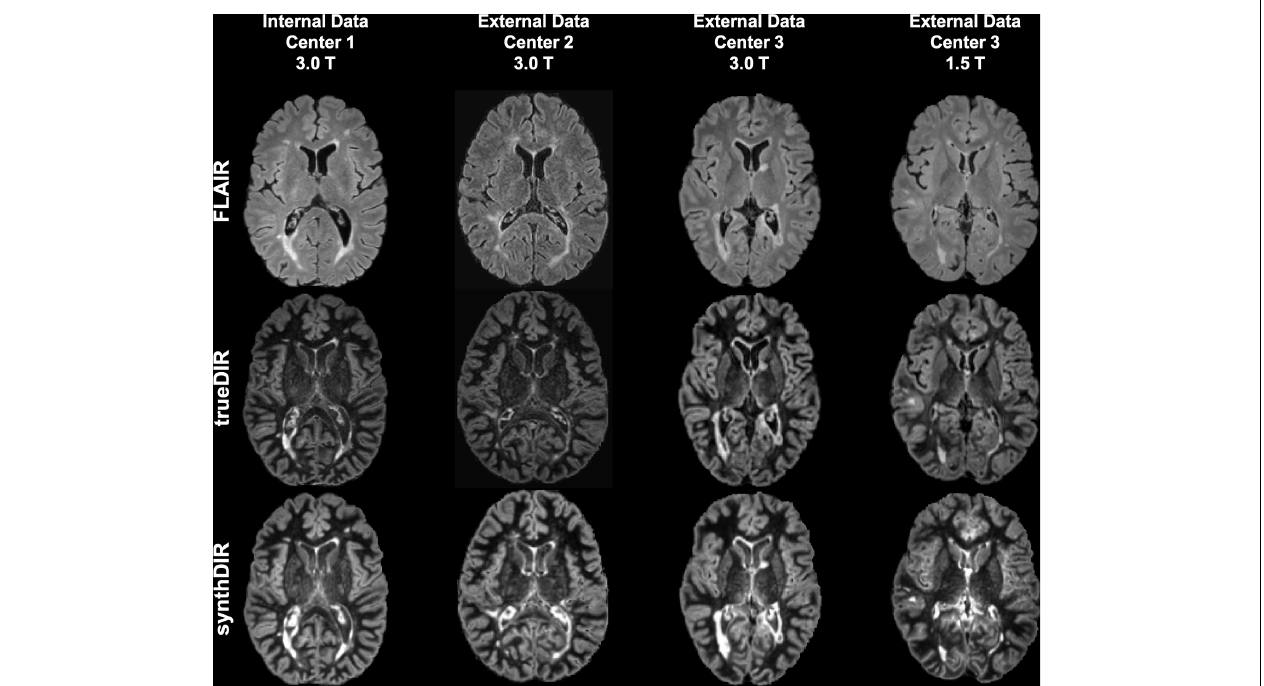
FIGURE 2 | Exemplary images of FLAIR, trueDIR, and synthDIR for all centers and